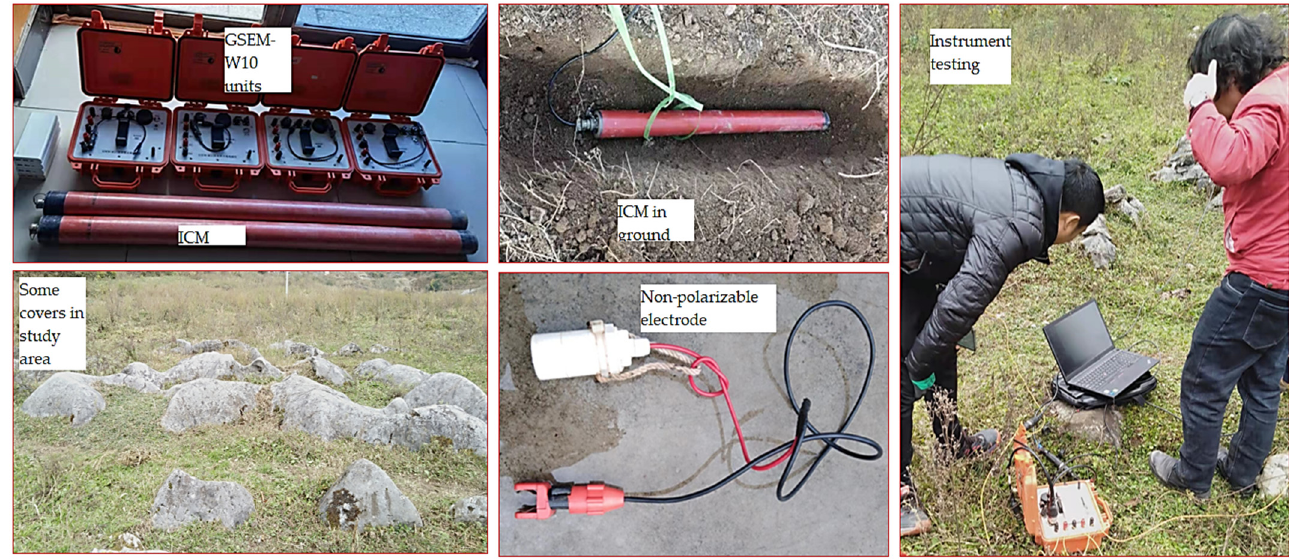
Figure 4. AMT field instruments used and the covers in the area. ICM: induction coil magnetometers.